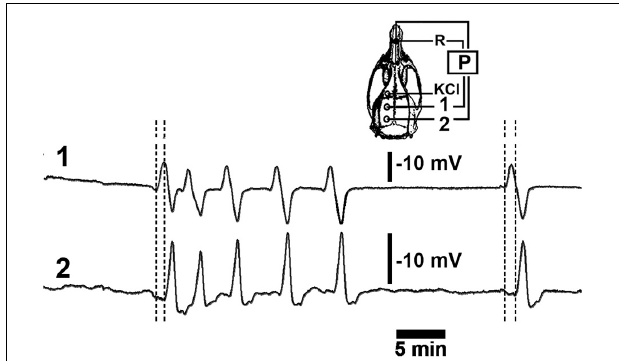
FIGURE 1 | A representative recording of DC slow potential changes during cortical spreading depression (CSD). Six episodes of CSD were elicited by applying a cotton ball soaked with a 2% KCl solution on the frontal cortex over a 30-min period at the point marked “KCl” on the skull diagram. The left hemisphere (skull diagram) shows recording positions 1 and 2 on the parietal cortex as well as the position of the reference electrode (R) on the nasal bones. Vertical calibration bars equal to 10 mV for the P recordings. Horizontal bar equals 5-min.